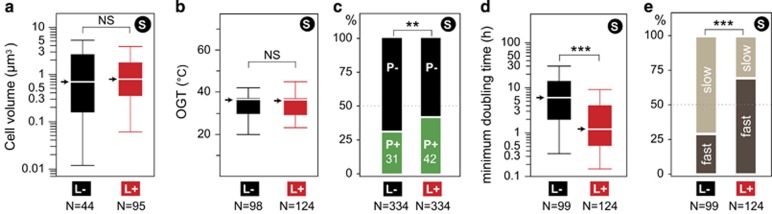
Analysis of the effect of species' (S) life-history traits on the distribution of lysogens. Box-plots of the distribution of the average cell volume (a) and optimal growth temperature (OGT, b) among the species with lysogens (red, L+) or lacking them (black, L−) (NS – nonsignificant differences: P>0.1, Wilcoxon test). (c) Proportion of species including bacterial pathogens (green, P+) or lacking them (black, P−) among species with lysogens (L+) or lacking them (L−) (**significant difference: P<10−3; χ2 test). Differences remained significant when controlling for genome size (P<10−4, stepwise regression) and phylogeny (P<10−4, generalized estimation equations analysis). (d) Box-plot of the distribution of the minimal doubling time under optimal conditions (d) among species with lysogens (L+) or lacking them (L−) (***significant difference: P<10−4, Wilcoxon test). Differences remained significant when controlling for bacterial genome size and phylogeny (P<10−4, generalized estimation equations analysis). (e) Proportion of fast (dark brown) and slow growers (light brown) among non-lysogens (L−) and lysogens (L+) (***significant difference: P<10−4, χ2 test). Arrows indicate medians.